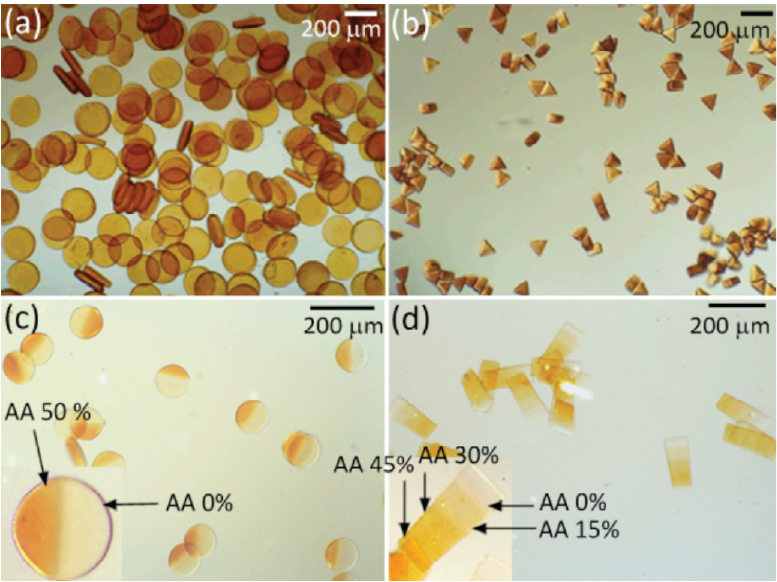
and 1 M FeCl 3 2 OH at 4